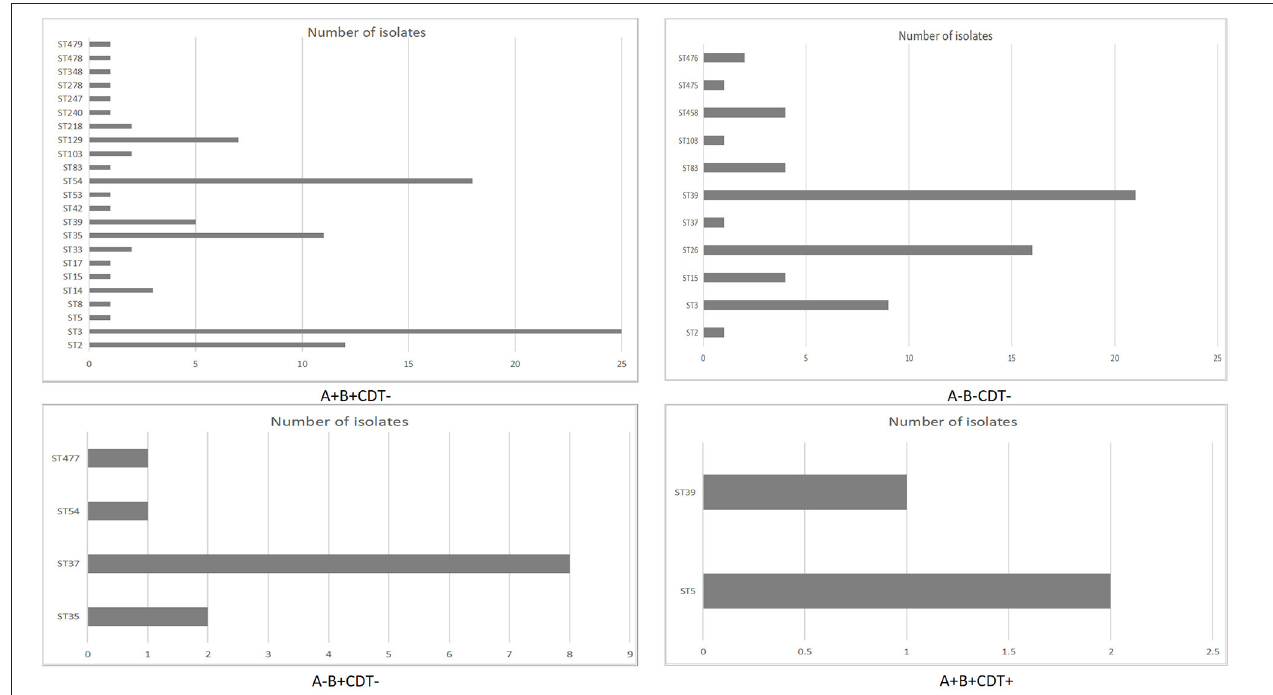
FIGURE 2 | The relationship of sequence types and toxin genes of C. difficile isolates.